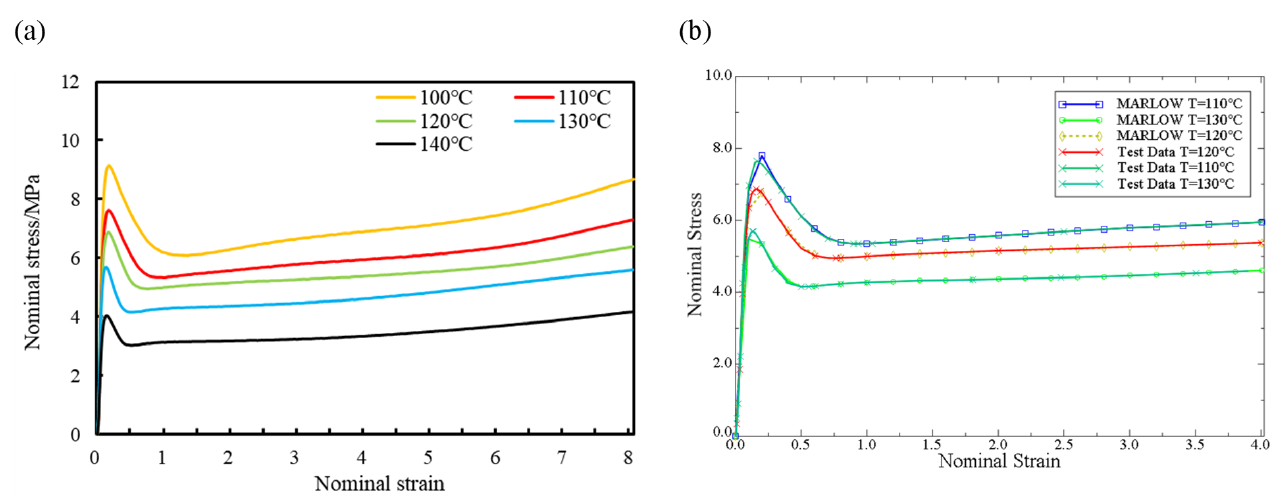
Figure 10. Nominal stress-strain curves of industrial PP. ( a ) Experimental value, ( b ) Fitting of the Marlow